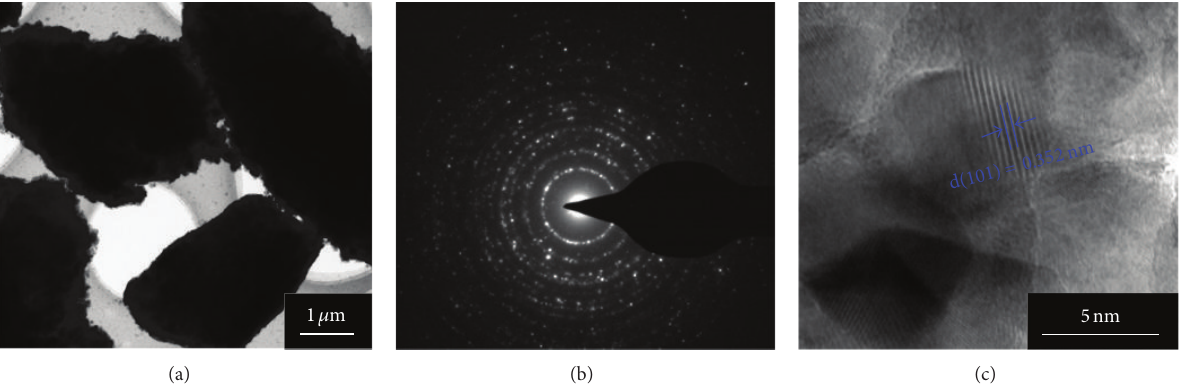
Figure 5: (a) TEM images, (b) the selected electron diffraction patterns, and (c) HRTEM images of the wood-templated TiO 2 .